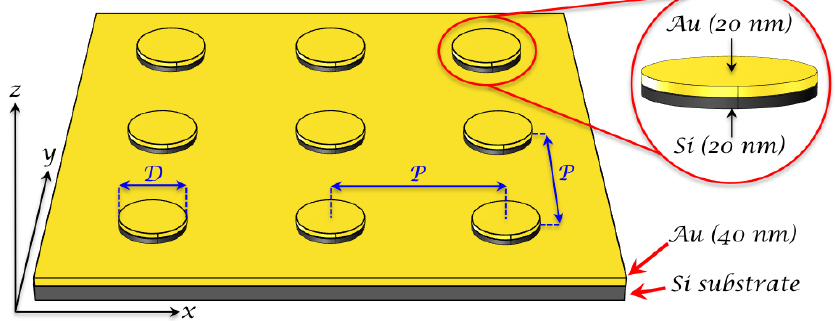
Figure 1. Scheme of the Au/Si disk-shaped nanoresonator array on gold film. D and P correspond to the nanodisk (ND) diameter and the period between the nanodisks, respectively. P is identical along x -axis and y -axis. In the red zoom are indicated the thicknesses of Si and Au layers constituting the bilayer of a hybrid nanodisk. An adhesion layer of Ti (2 nm) is used between Si substrate and gold